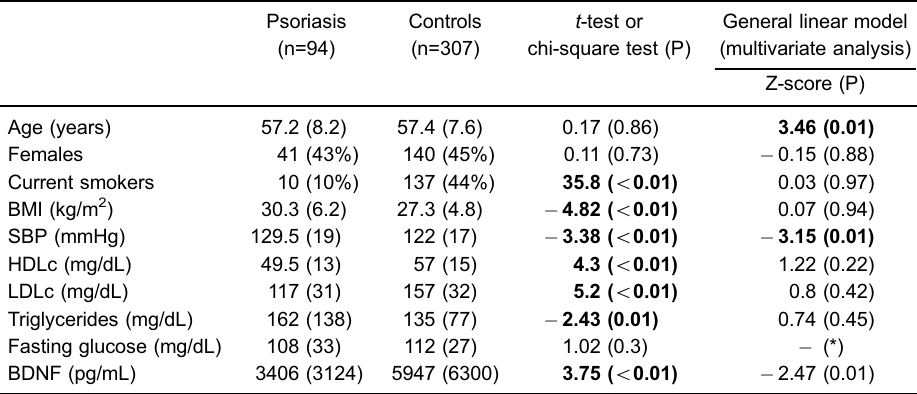
Table 1. Clinical and demographic data of psoriasis patients and controls.